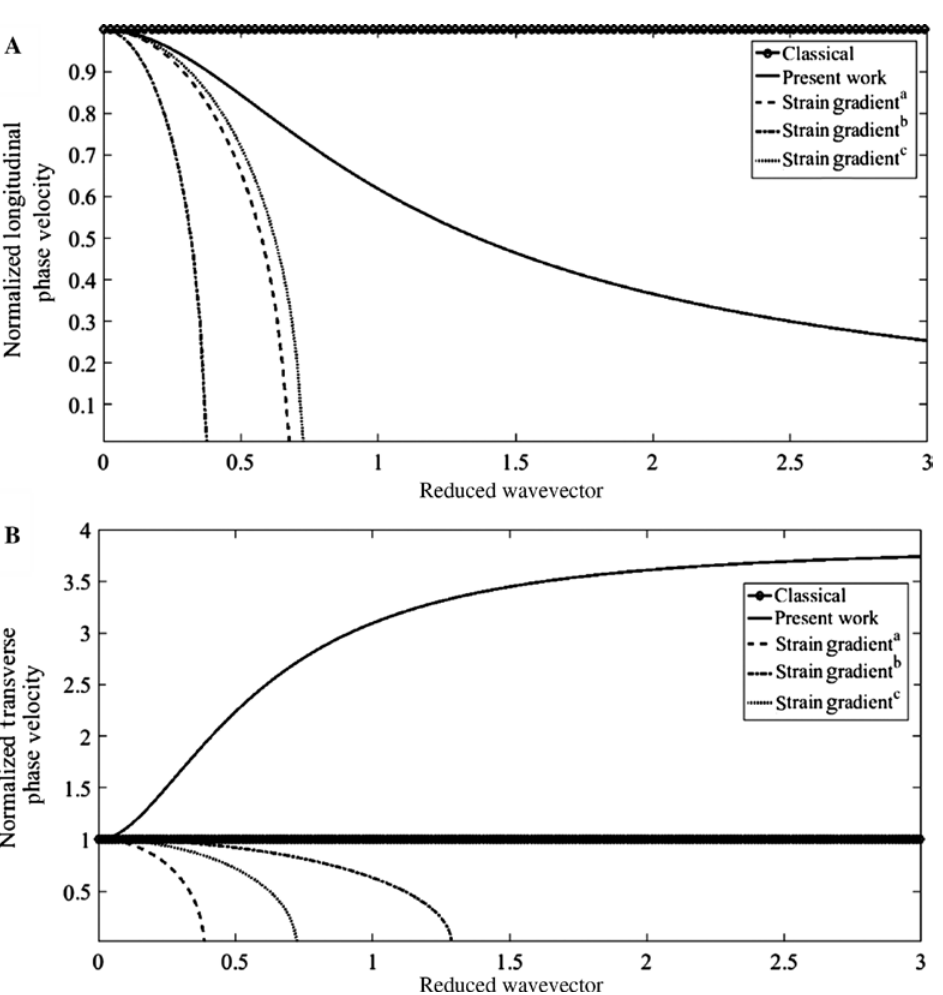
Figure 2: The normalized longitudinal phase velocity (A), and the normalized transverse phase velocity (B), of Si. a, b, and c curves were plotted according to the SGT and predicted mechanical constants in [8], [36], and [3],